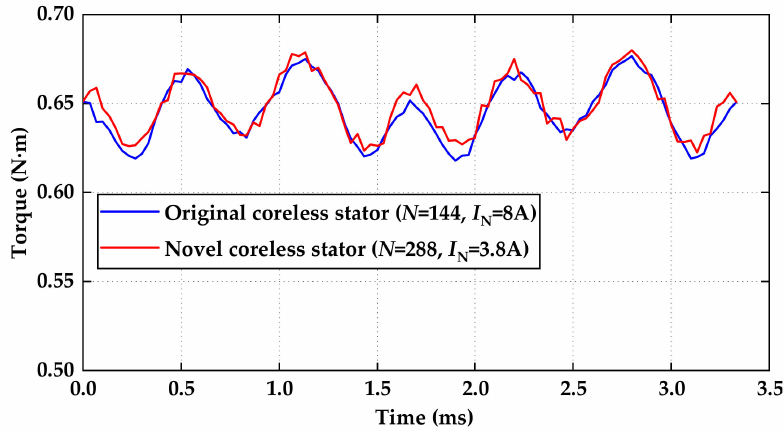
Figure 9. Rated torque of the machine with different coreless